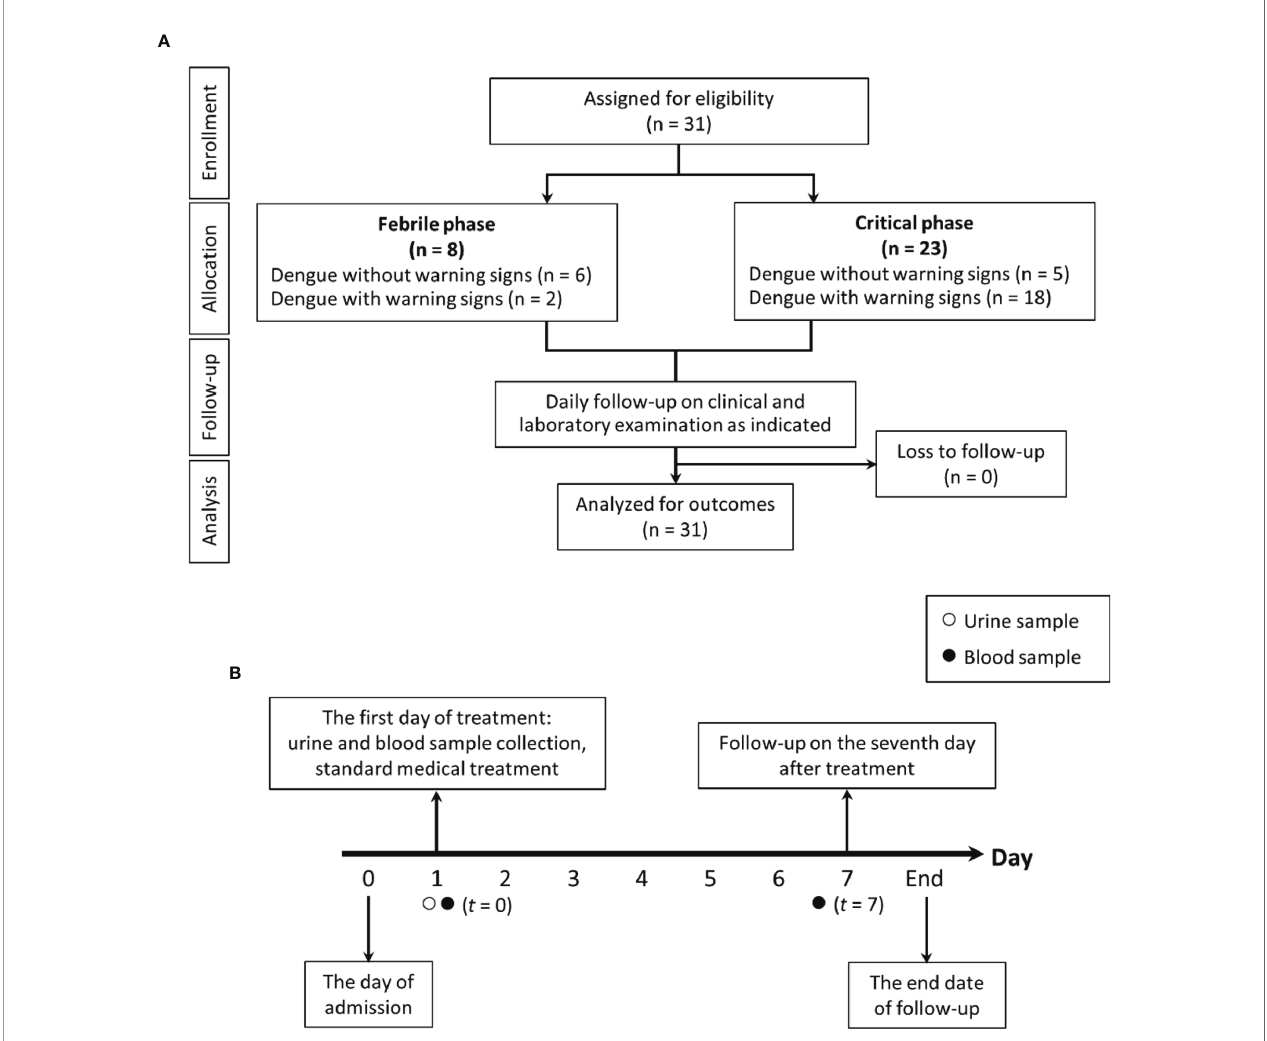
FIGURE 1 | The schematic diagram demonstrates for study fl ow diagram (A) and timeline of the study design (B)